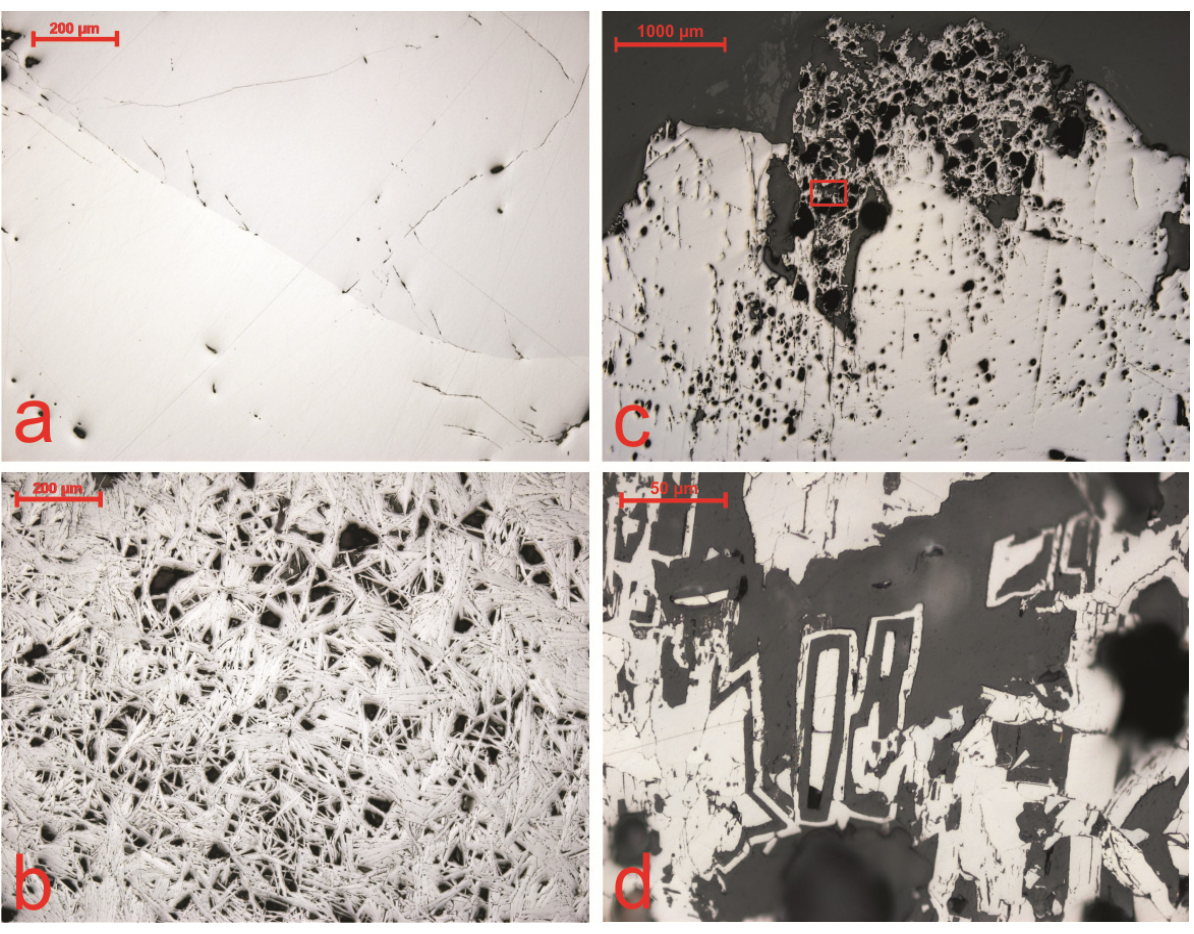
Figure 2. Photomicrographs in plane polarized reflected light showing the different ore textures of ferberite and reinite. ( a ) Large primary ferberite crystal (type-1) showing simple twinning; ( b ) Reinite (type-2) composed of randomly oriented fibrous ferberite crystals forming a porous aggregate; ( c ) Replacement of primary ferberite (type-1) by porous secondary ferberite (type-3); The rimmed box indicates the area of view in ( d ); ( d ) Secondary ferberite (type-3) is characterized by skeletal growth texture surrounded by empty cavities. The area of this view is indicated by a rimmed box in ( c